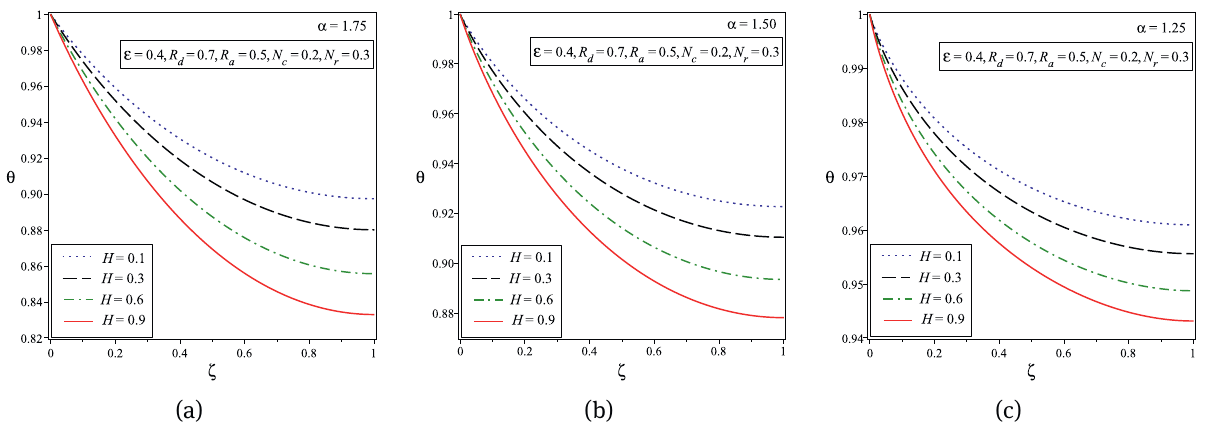
Fig. 7: The ADSTM solutions for a different value of H and for (a) α = 1.75 (b) α = 1.5 (c) α = 1.25 .